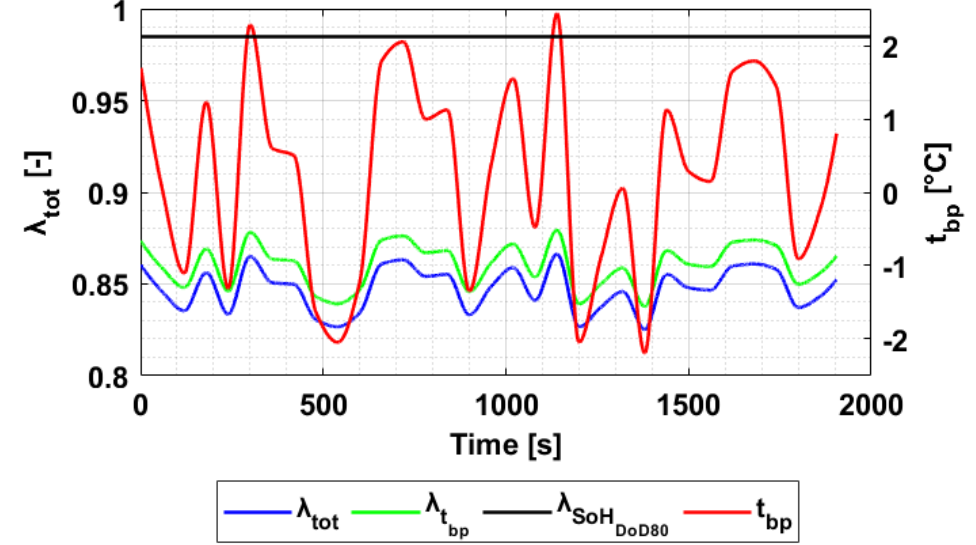
Figure 23. Combined effect of the battery pack temperature and the battery ageing level on λ tot for DM25 in the case of a battery with 200 life-cycles completed and DoD80.